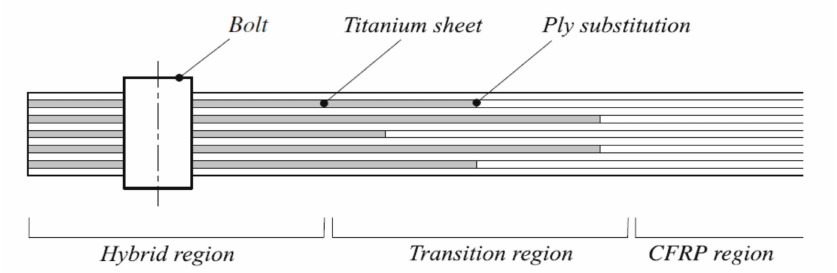
Figure 17. Hybrid CFRP / titanium composite at the bolted joint location